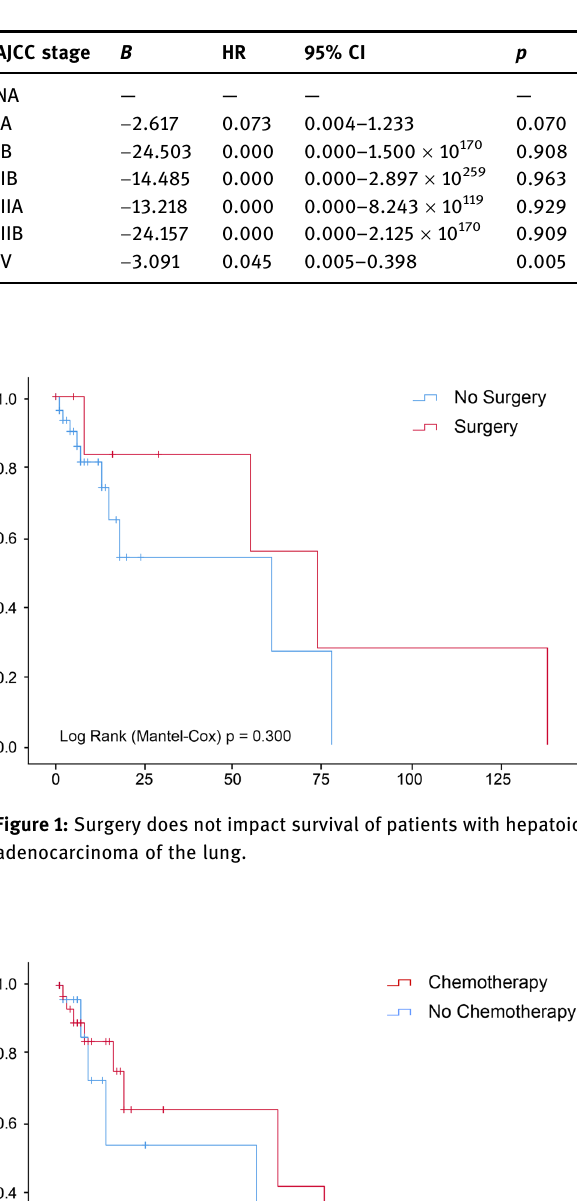
Table 2: AJCC stage is the only hazard factor in the Cox proportional hazards model